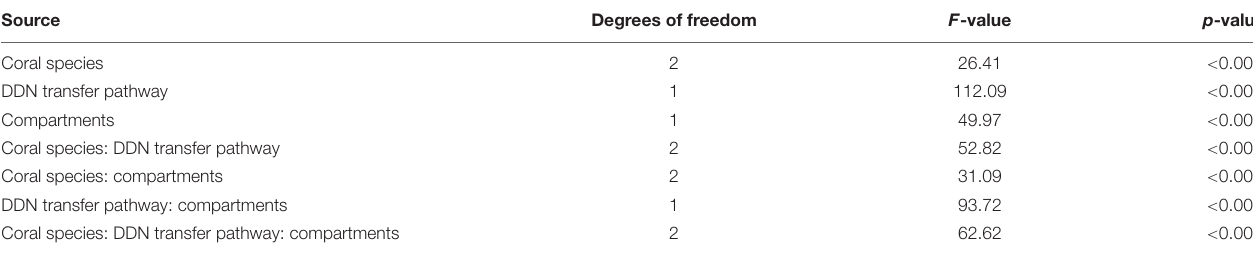
TABLE 3 | Results of a three-way factorial ANOVA with coral species, compartments and DDN transfer pathway as explanatory variables on the dependent variable: DDN assimilation rates. Source